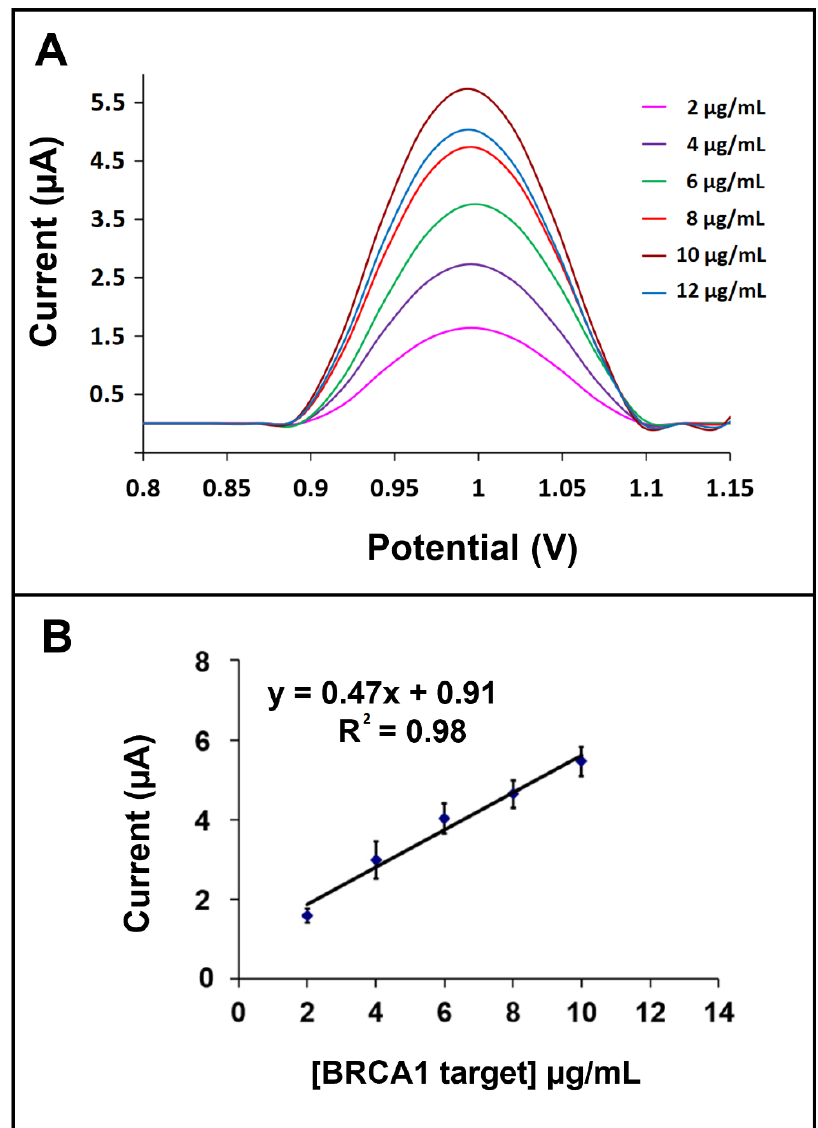
Figure 9. ( A ) DPVs. ( B ) Calibration plot with the average guanine signal of hybridization between the 6 µg/mL BRCA1 probe and the 2 µg/mL, 4 µg/mL, 6 µg/mL, 8 µg/mL, and 10 µg/mL BRCA 1 target on the surface of GO-IL-PGE ( n = 3).